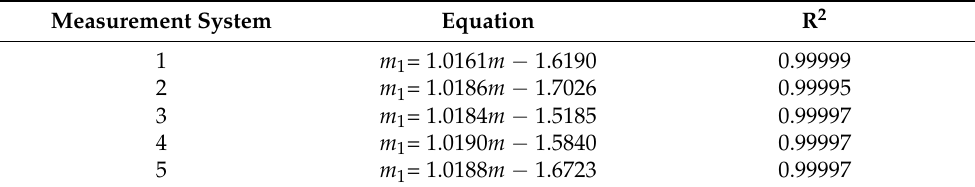
Table 2. Equation and coefficient of determination (R 2 ) between the true value m and measured value m 1 .